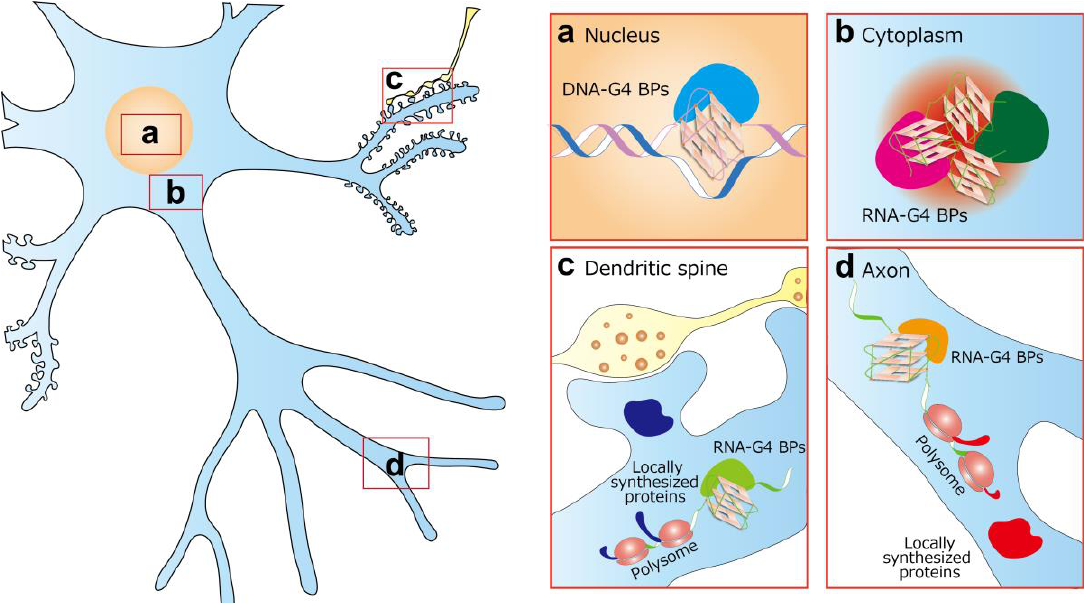
Figure 3. Multiple roles and pharmacological targets of G-quadruplex in the neuron. ( a ) In the nucleus, DNA-G4 may be involved in transcriptional modifications, telomere maintenance, and epigenetic modifications, together with DNA-G4 binding proteins (BPs). ( b ) In the cytoplasm, RNA-G4 is involved in the metabolism of RNA granules, including interactions with RNA-G4 BPs and phase separations. ( c , d ) RNA-G4 is also involved in the transport, stability, translation, and subcellular localization of dendritic ( c ) and axonal ( d ) mRNAs. A detailed understanding of these processes will inform a new therapeutic strategy for neurological diseases.